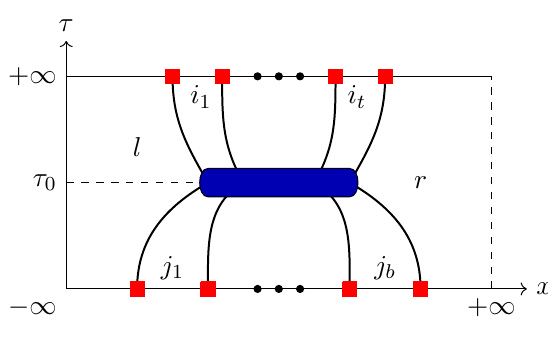
Figure 6 . Typical form of an instanton in 2d LG